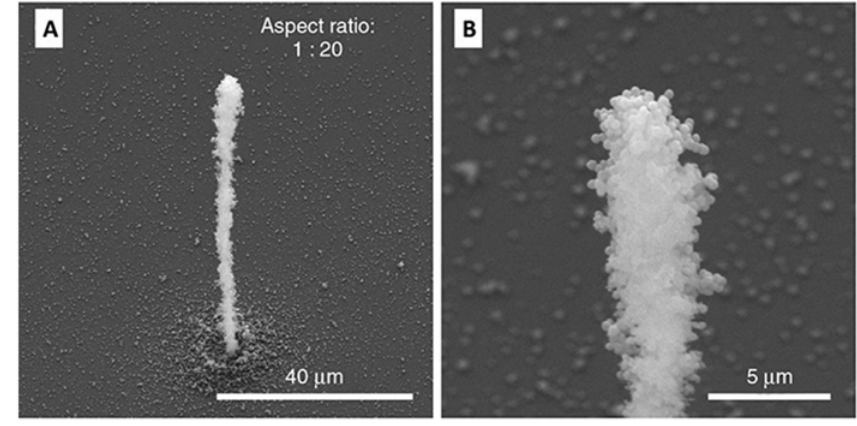
Figure 15: Three-dimensional structure consisting of several thousands of silicon nanoparticles generated by laser printing. Pillar of 60 μ m high and 3 μ m width (A) and the zoom on the top of the pillar shows that it is composed of silicon nanoparticles